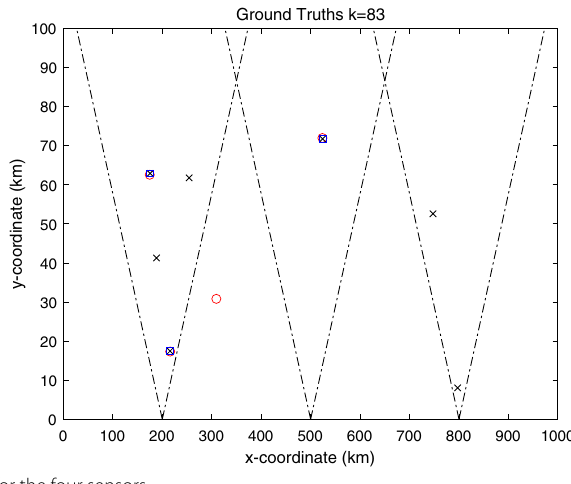
Fig. 2 The fields for the four sensors